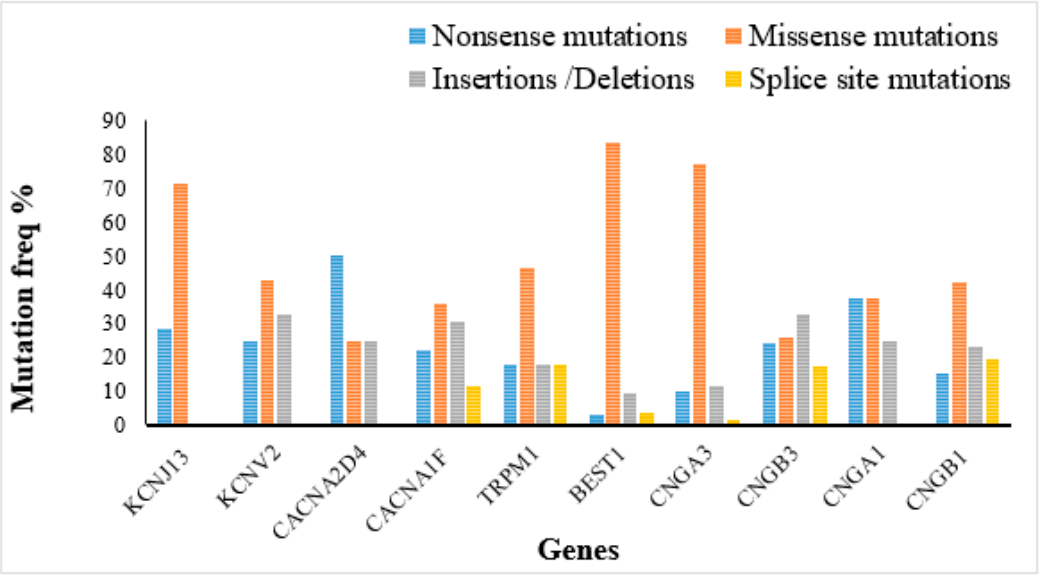
Figure 3. Distribution of disease mutations in ocular ion channel genes. (Based on HGMD and OMIM).